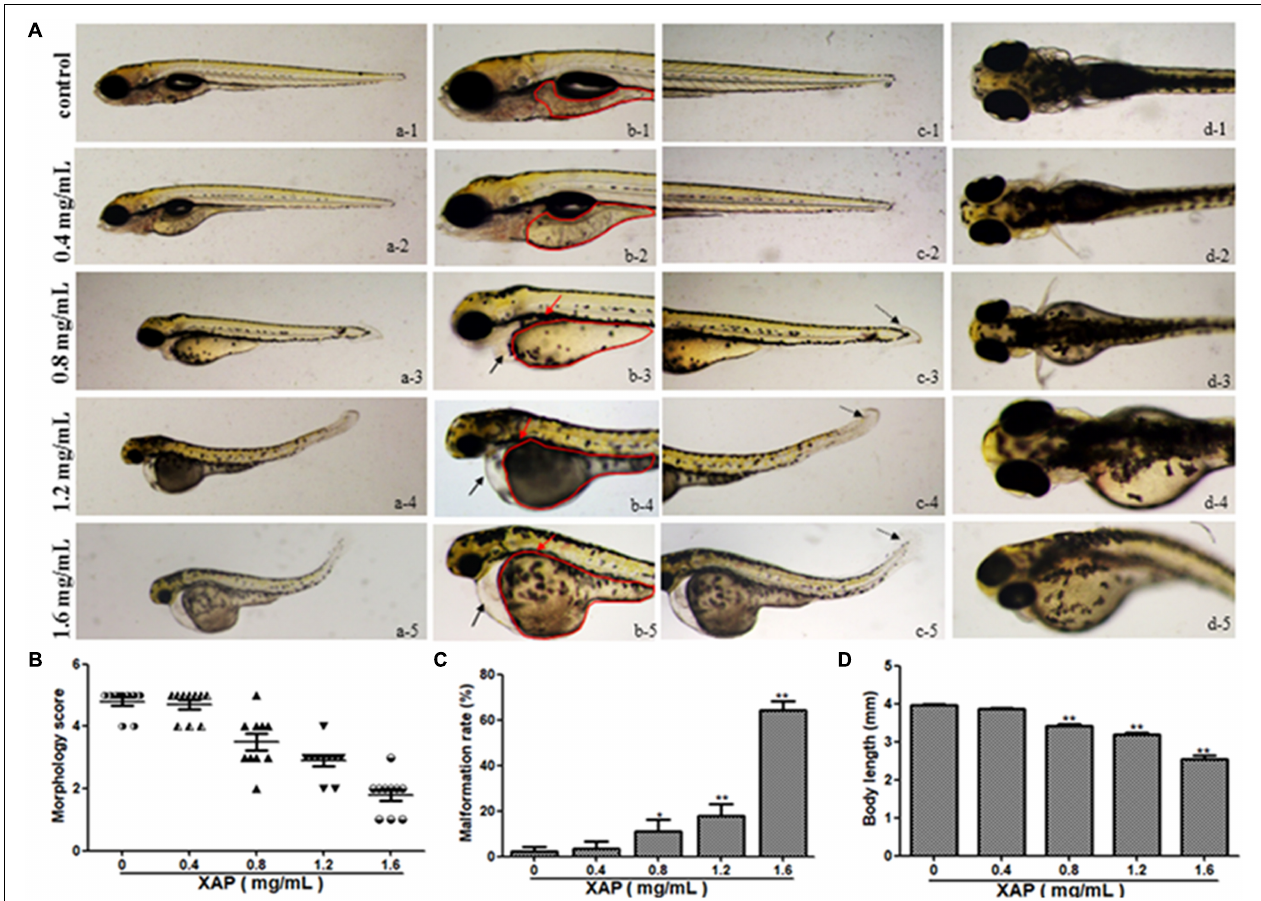
FIGURE 2 | Body morphology effect of XAP exposure in zebrafish embryos at 120 hpe. (A) Representative lateral and ventral views of zebrafish larvae. Swim bladder deficiency is indicated by a solid red arrow. Yolk retention is indicated by the red outline. Pericardial edema is indicated by a solid black arrow. A slightly curved tail is indicated by a dotted black arrow. (B) Morphological scoring of XAP-exposed zebrafish embryos at 120 hpe. (C) Malformation rate of XAP-exposed zebrafish embryos at 120 hpe. (D) Body length of XAP-exposed zebrafish embryos at 120 hpe. ∗ P < 0.05, ∗∗ P < 0.01 versus